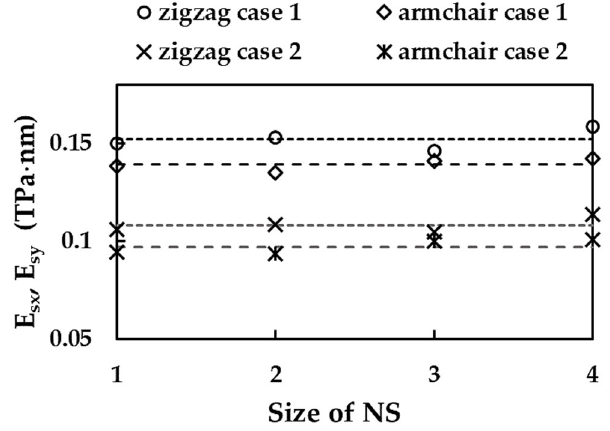
Figure 7. Surface Young’s moduli, E sx (zigzag) and E sy (armchair), of the InNNSs for the four sizes (Table 3) and the two cases of the input parameters (Table 2). The dash lines represent the average value of the respective surface Young’s modulus.